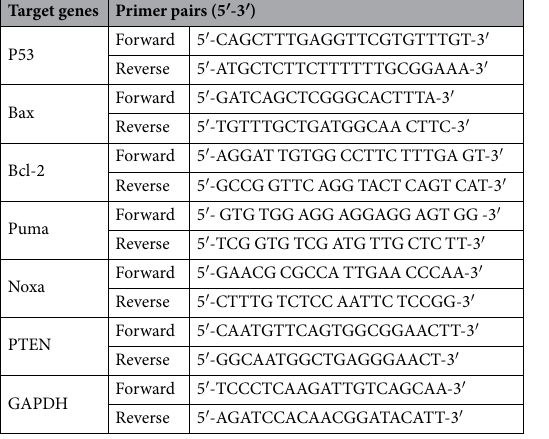
Table 1. Sequence of primers used in